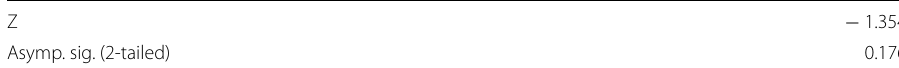
Table 5 Wilcoxon signed-rank test statistic, online course-independent study Z